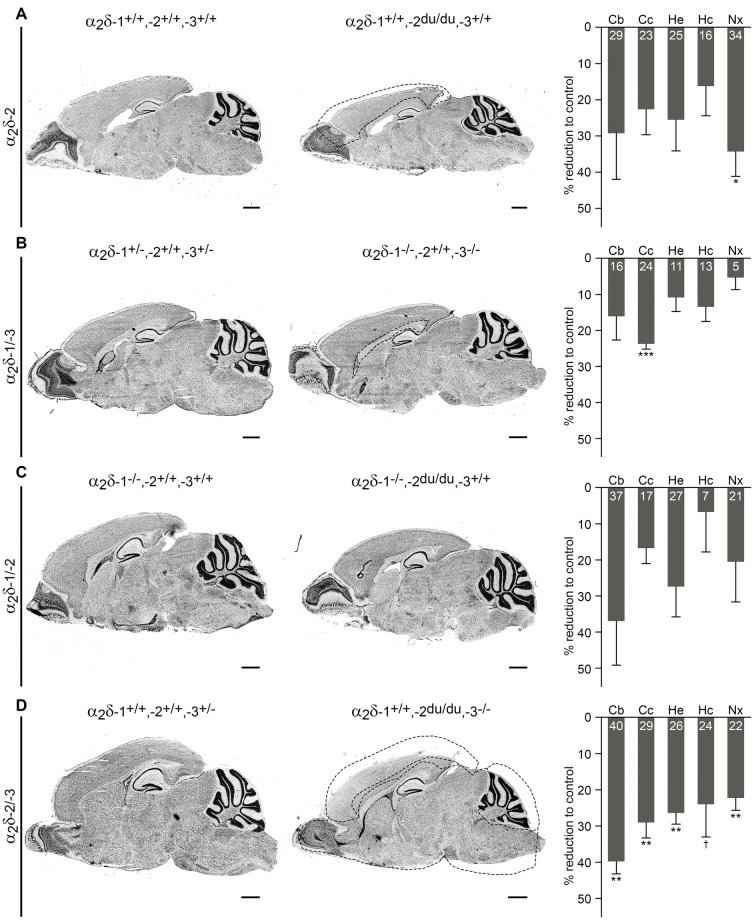
Volumes of distinct brain regions are decreased in adult ducky and α2δ double knockout mice. Representative micrographs of Nissl-stained sagittal cryosections obtained from adult (8–13-weeks-old; A,B) and juvenile (3–4-week-old; C,D) mice. Consecutive slides were used for volume quantification of specific brain regions by applying the Cavalieri principle. Data from three mice per genotype were averaged and bar graphs depict means of respective knockout mice ± SEM, calculated as percentage reduction to corresponding controls (indicated with numbers in bars). Dashed lines in micrographs illustrate significantly decreased brain areas in knockout mice (right picture of each panel) compared to respective controls (left picture of each panel). (A) Ducky mice showed a generally reduced volume of all analyzed brain regions, with neocortical size being significantly decreased by 34%. (B) While the majority of analyzed structures were only slightly affected in α2δ-1/-3 double knockout mice, a specific volume reduction of 24% was found in the corpus callosum. (C) Brain regions of α2δ-1/-2 double knockout mice were not significantly different from control animals which already lacked α2δ-1. However, additional knockout of α2δ-2 caused an obvious trend towards reduced volumes of the cerebellum (37%), whole hemisphere (27%), and neocortex (21%). (D) α2δ-2/-3 double knockout mice showed a drastic volume reduction of all analyzed brain regions ranging from 22 to 40%. The highly significant decrease of the cerebellum, whole hemisphere, and neocortex was similar to the one found in α2δ-1/-2 double knockout mice. Furthermore, the size of the corpus callosum was significantly reduced by 29%. Confer Supplementary Table 2 for raw data of individual mice and respective genotypes. Abbreviations: Cb, cerebellum, Cc, corpus callosum, He, whole hemisphere, Hc, hippocampus, Nx, neocortex. Statistics: unpaired t-test with Holm–Sidak correction for multiplicity (for p-values see Supplementary Table 2). Symbols in graphs indicate corrected significance levels compared to control: †p < 0.06; *p < 0.05; **p < 0.01; ***p < 0.001. Scale bars, 1 mm.